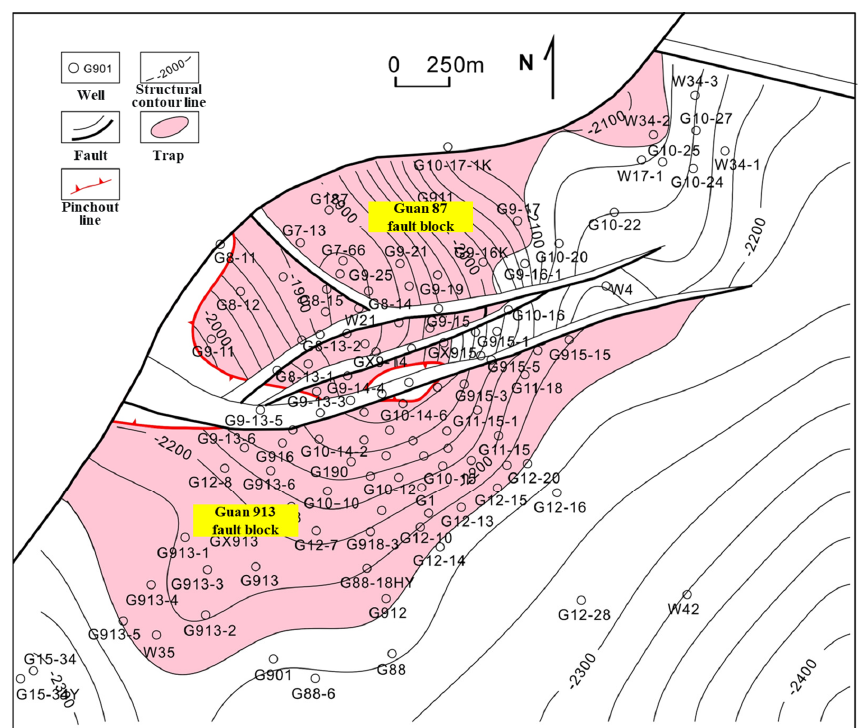
Figure 1. The tectonic location of study area.